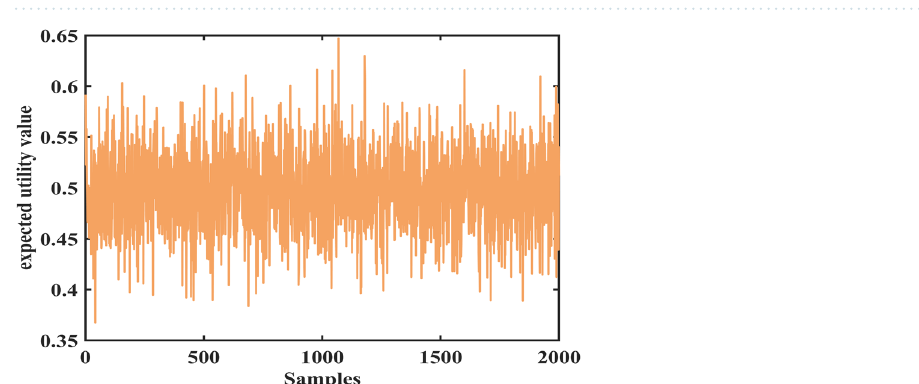
Figure 4. The expected utility value of the laser gyro.